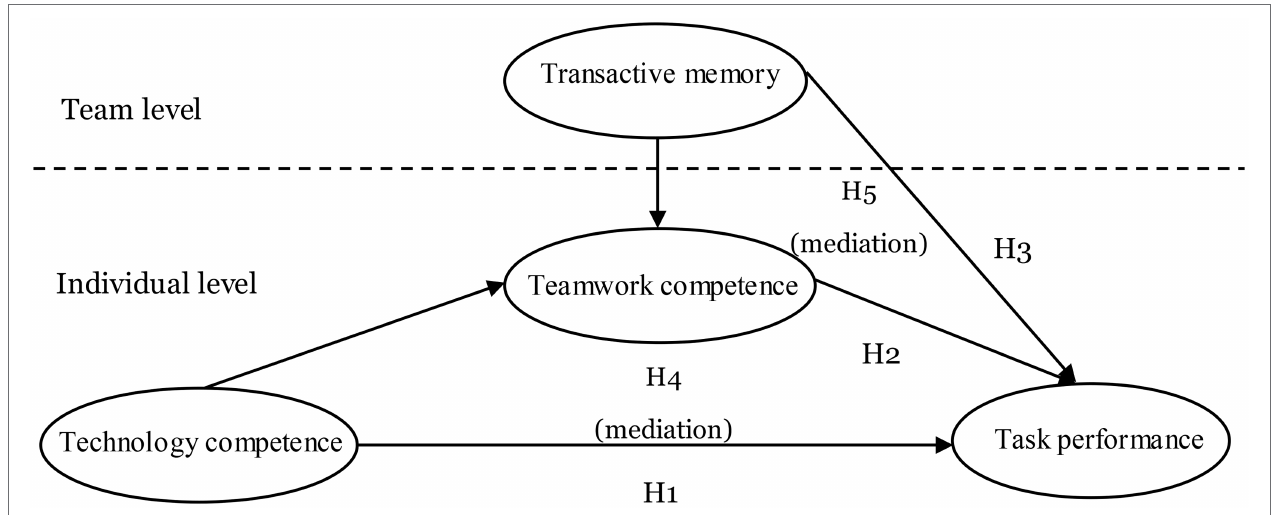
FIGURE 1 | The research